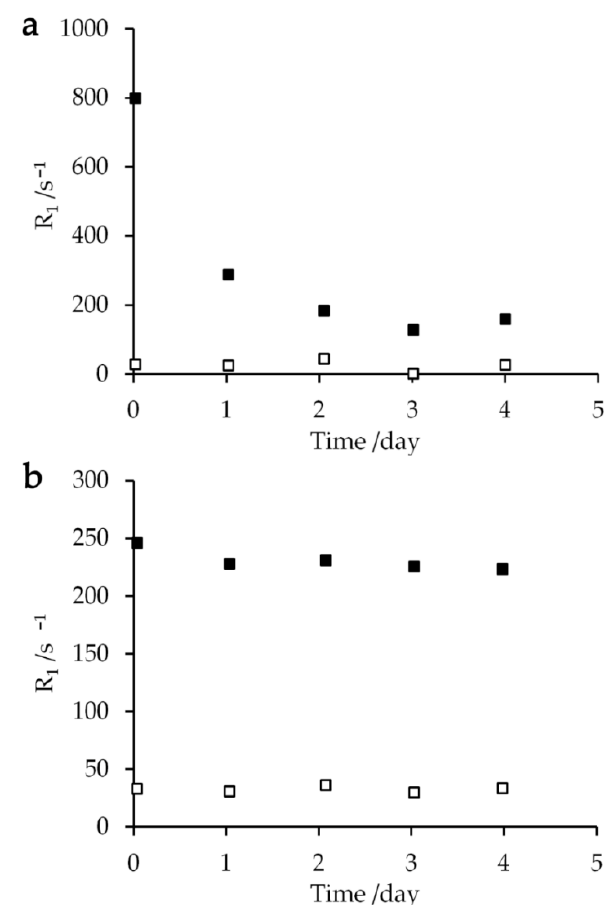
Figure 6. Extracellular (closed square) and intracellular (open square) relaxation rates R 1 plotted against the time after mixing 10 µ L of ( a ) 250 mM aqua Gd 3 + or ( b ) 250 mM Gd-DOTA solutions with a 40 µ L glycerol- E. coli sample at 273 K.